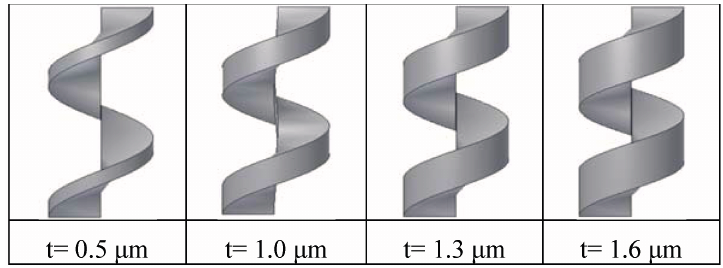
Figure 5. Computer Aided Design (CAD) of Archimedes screws without a central